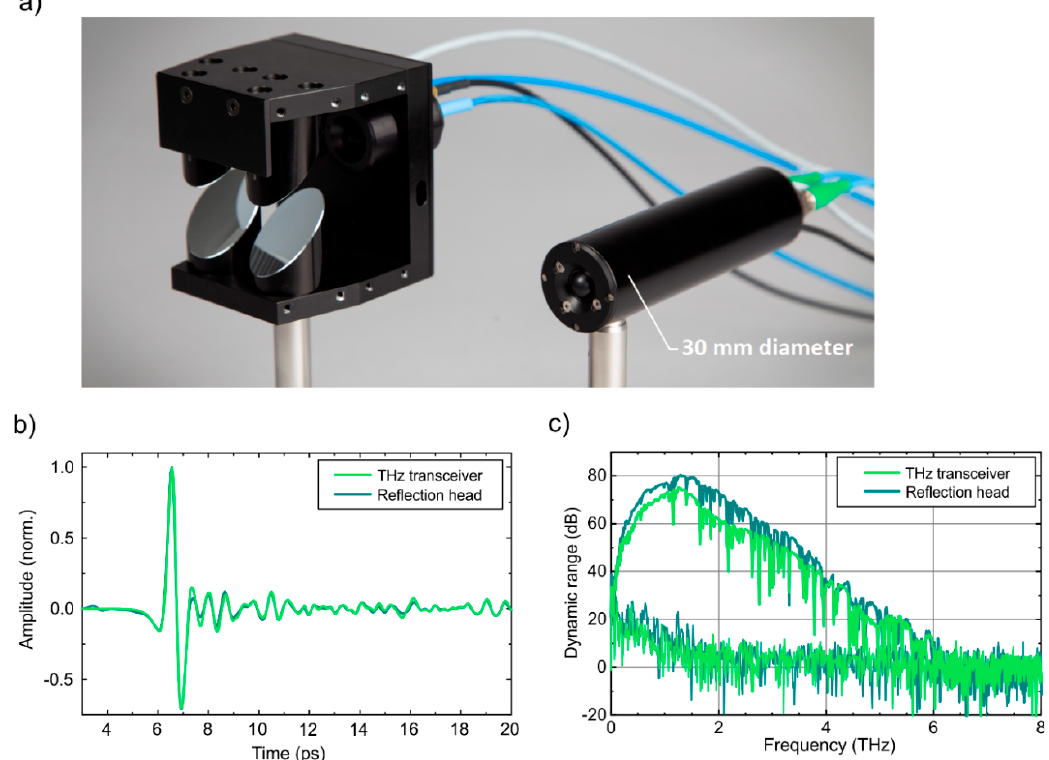
Figure 6. Comparison of THz reflection measurements for a reflection head with separate THz modules and angled beam path versus the integrated THz transceiver module. ( a ) A photograph of the (open) reflection head including its four parabolic mirrors and the fiber coupled THz transceiver module. In ( b ), the normalized THz pulse traces are compared, and ( c ) shows the corresponding dynamic range obtained by dividing the power spectrum by the spectral noise from a blocked THz path.